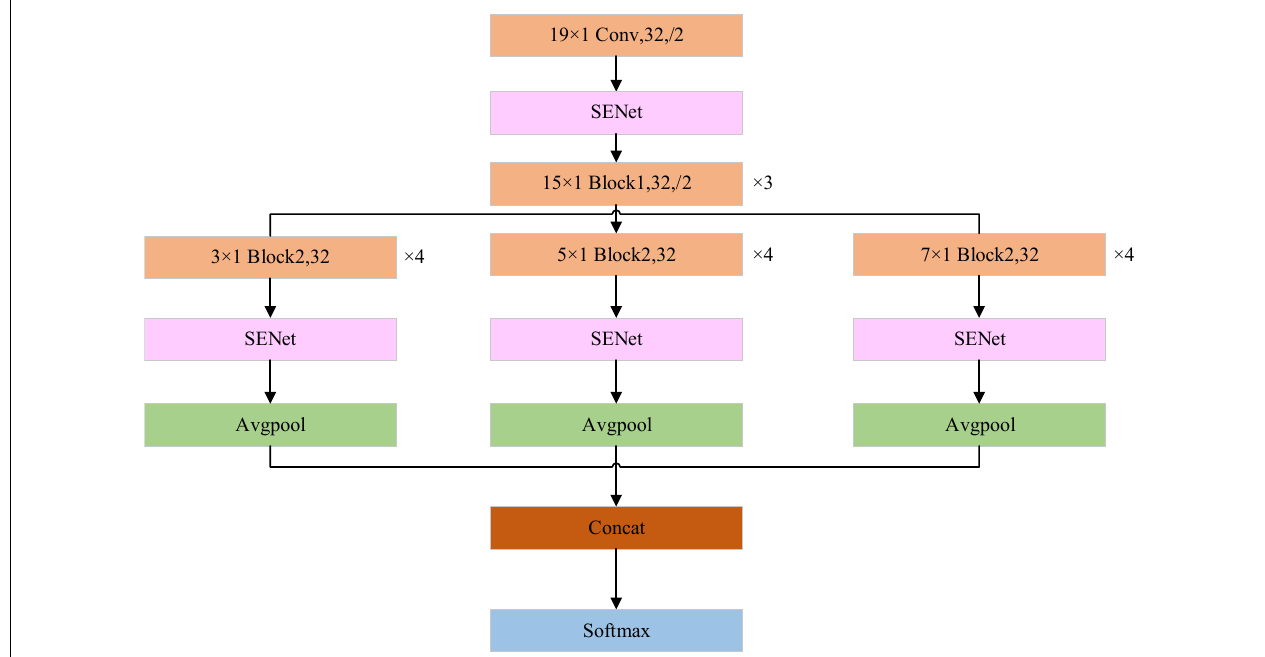
FIGURE 3 | Schematic of the ECGNet model showing the individual modules. Avgpool is the average pooling layer. Concat is the operator to concatenate the features of different scales, SoftMax is the function which calculates the probability that the sample belongs to each category. The maximum probability determines that the sample is assigned to the specified